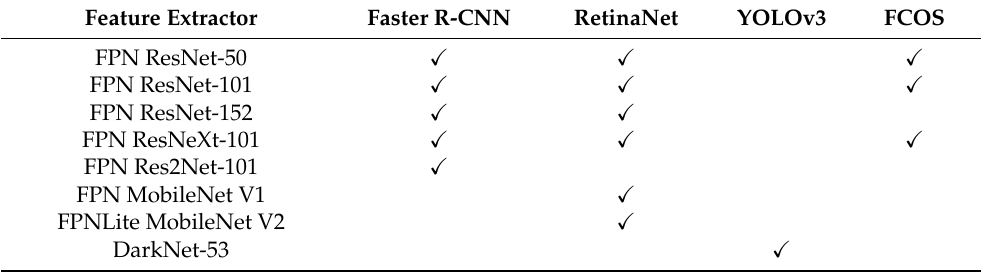
Figure 3. Convolutional blocks of each feature extractor. F is the number of convolutional filters, C refers to the cardinality of the ResNeXt block and S is the scale dimension of Res2Net block. Table 2. Combinations of deep learning meta-architectures and feature extractors used in the experimental